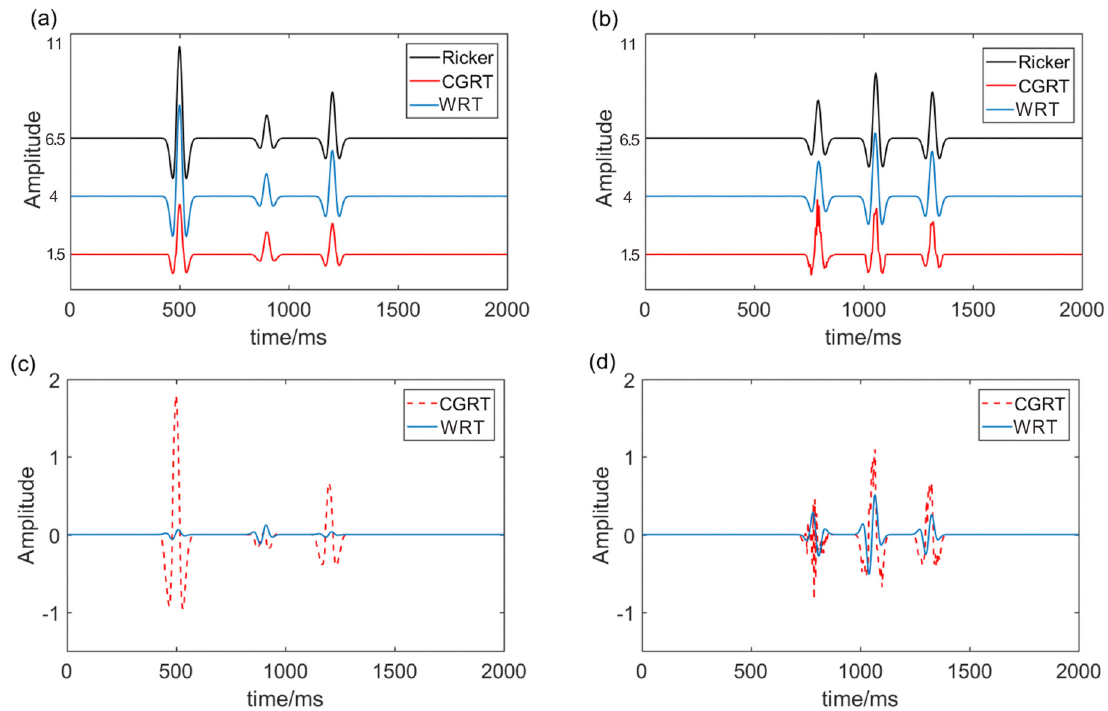
Figure 8. ( a ) Waveform at first trace; ( b ) waveform at reconstruction trace; ( c ) waveform residual at first trace; ( d ) waveform residual at reconstruction trace.